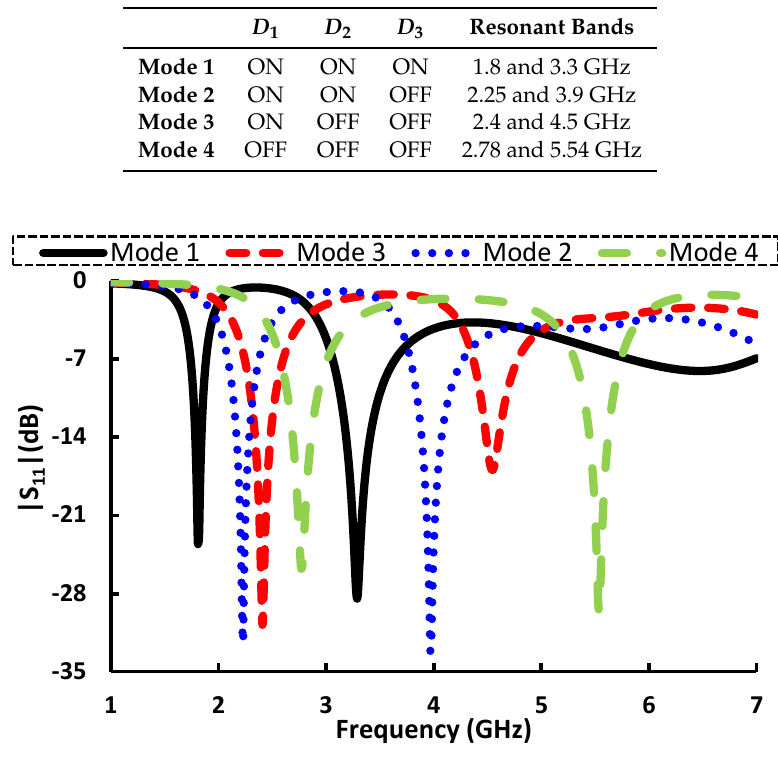
Figure 2. Reflection coefficient of the antenna for different operating